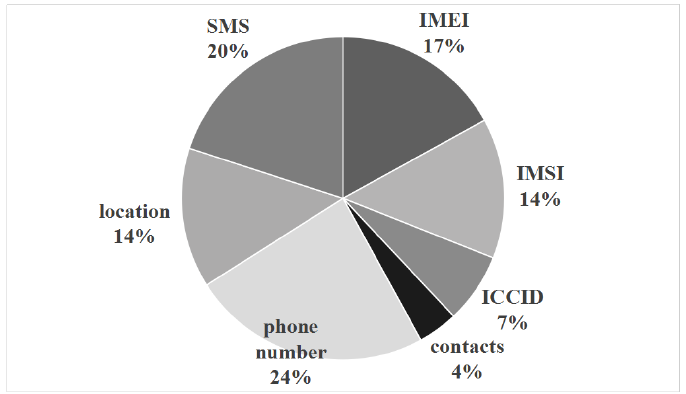
Figure 7. Proportion of privacy leakage